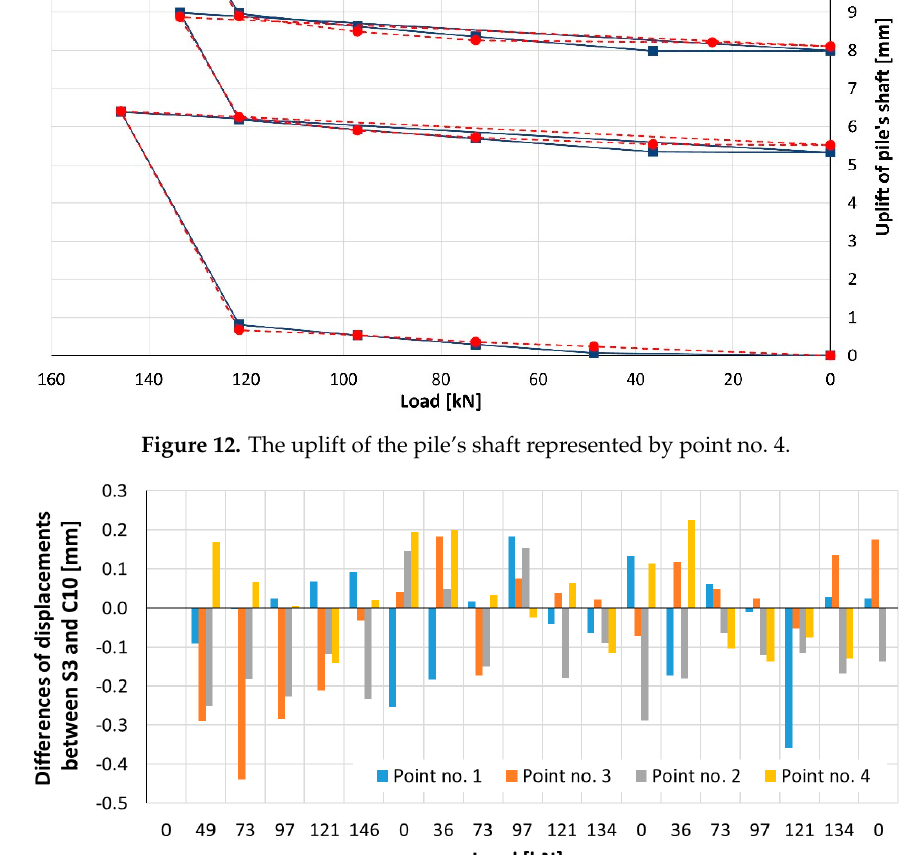
Figure 15. The relative displacement of pile shaft and the piston (pile foot) calculated for a pair of checkpoints no. 2 and no. 3. 4. Discussion Even though the idea of an Osterberg-like low-cost test of closed-end steel pipe piles (proposed by Baca) is still in a phase of a prototype, it seems that it has a market potential, at least when compared to the other time and money consuming testing procedures. It can be also used as a model test to determine soil capacity. The results of numerical simulations provided by Baca and Brz ą ka ł a [16] have shown comparability between the traditional SLT and the Osterberg test. The above-presented geodetic techniques provide a fully independent reference system of displacement control. The analytically defined limit value of the uncertainty of vertical displacement determination in the external reference system, not related to the tested object, was 0.3 mm for the total station and 2.0 mm for the scanner. When we compare the determined displacement values of the four checkpoints calculated from both geodetic methods, the biggest differences do not exceed